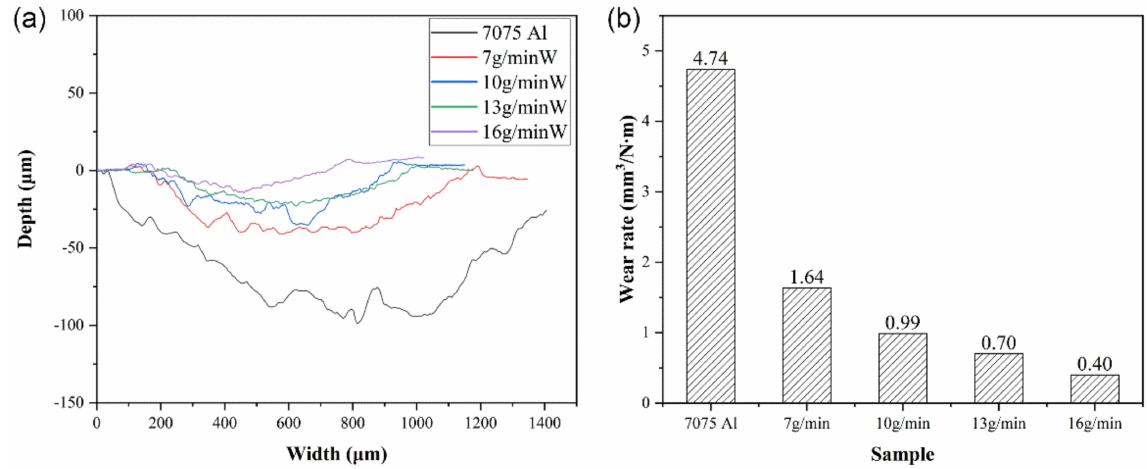
Figure 12. ( a ) Wear scar distribution curves and ( b ) wear rates of 7075 Al alloy and W/Al composite